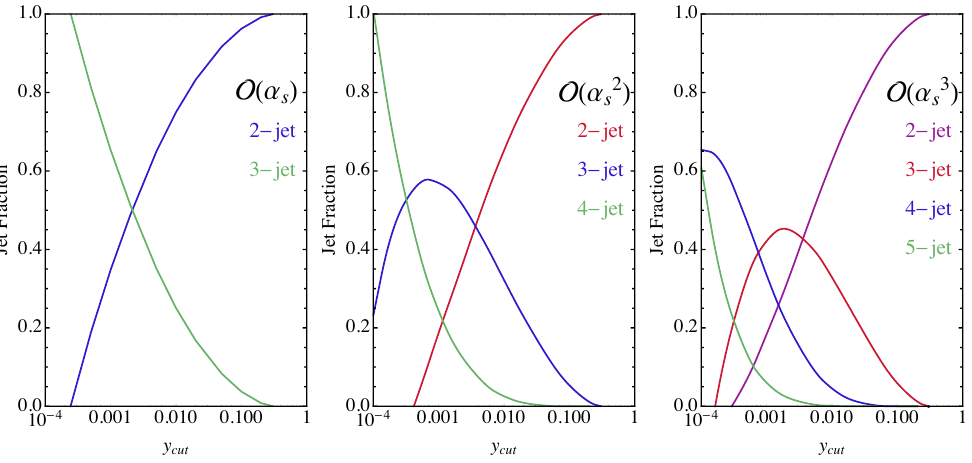
Figure 5 . Jet fractions at orders (cid:11) s , (cid:11) 2 width at that